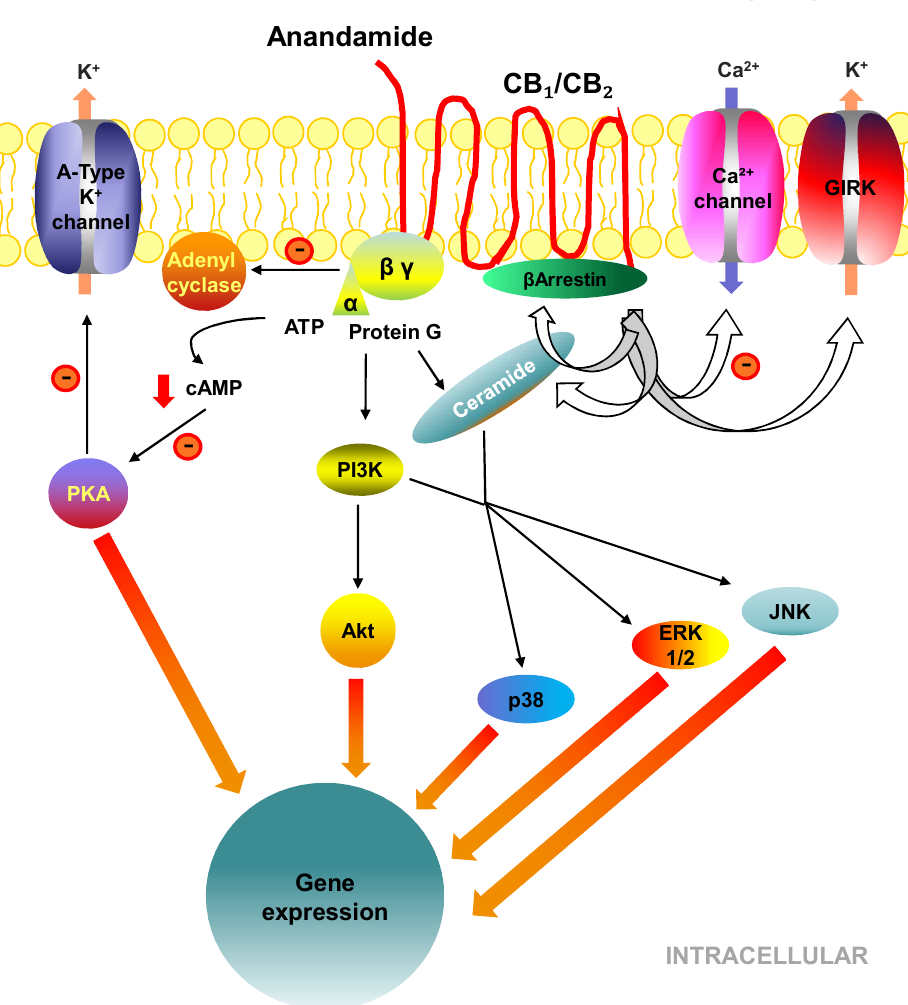
Figure 2. Molecular and cell signalling pathways of cannabinoid receptors.